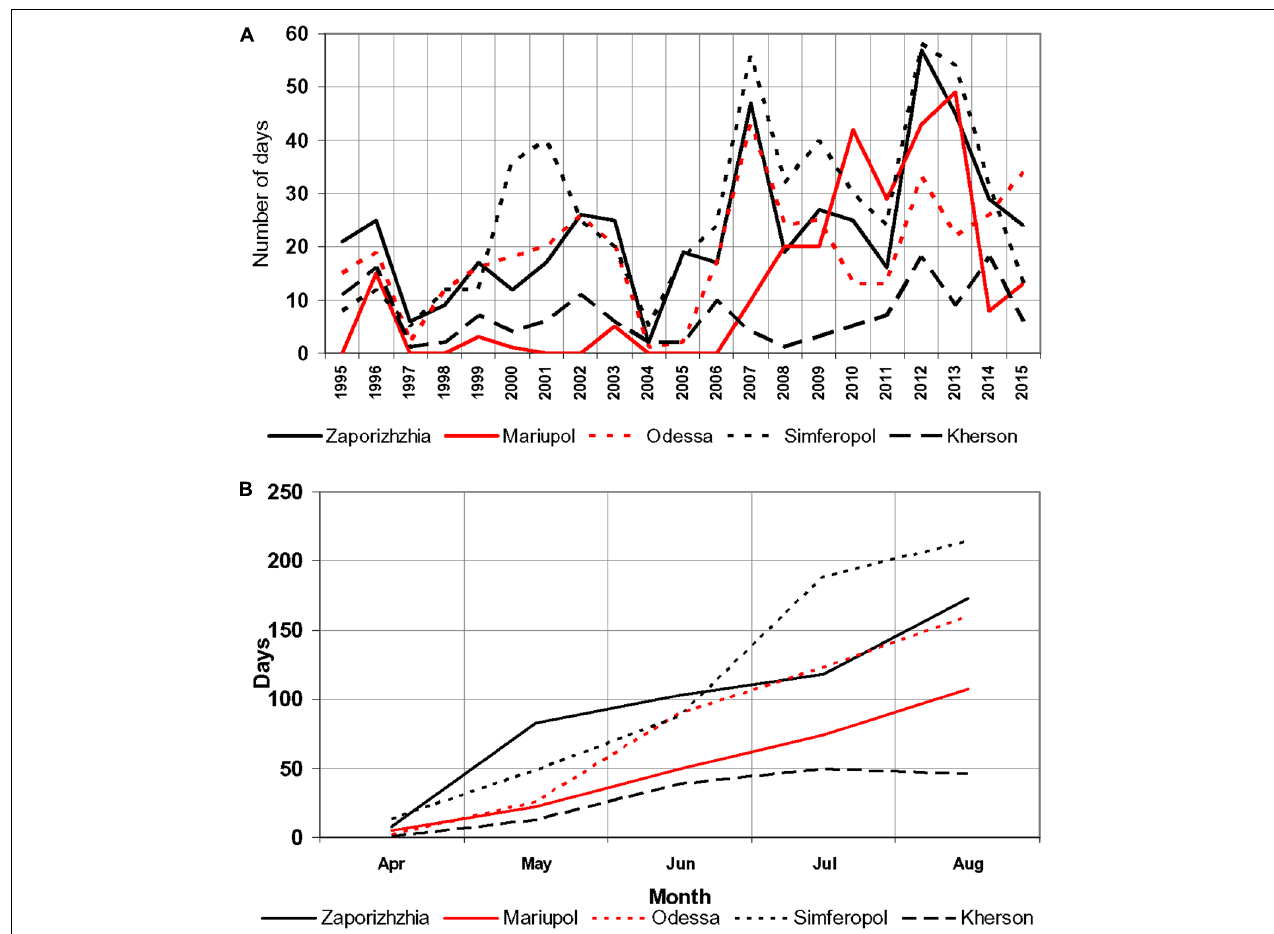
FIGURE 3 | Dynamics of the total number of days with dry wind (A) , and the total sum of days with dry wind (B) by months of growing season (April–August) of 1995–2015 at the stations located in the Black Sea Steppe